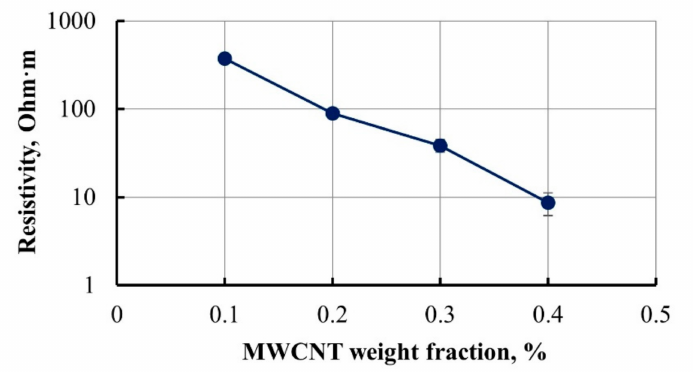
Figure 1. The resistivity of the epoxy matrix modified with different content of